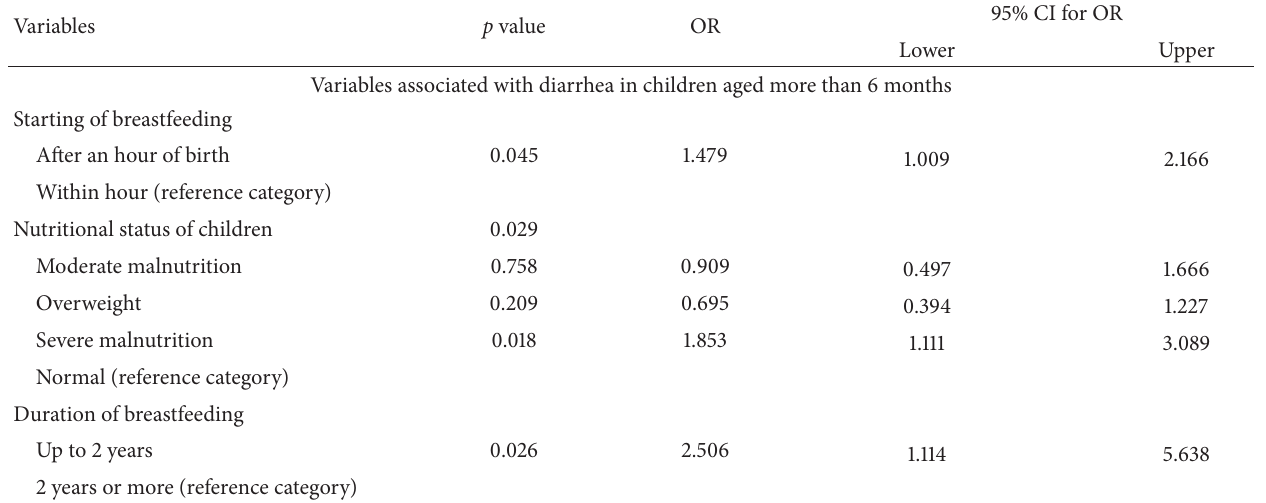
Table 5: Variables associated with diarrhea and cough/cold episodes in children age more than 6